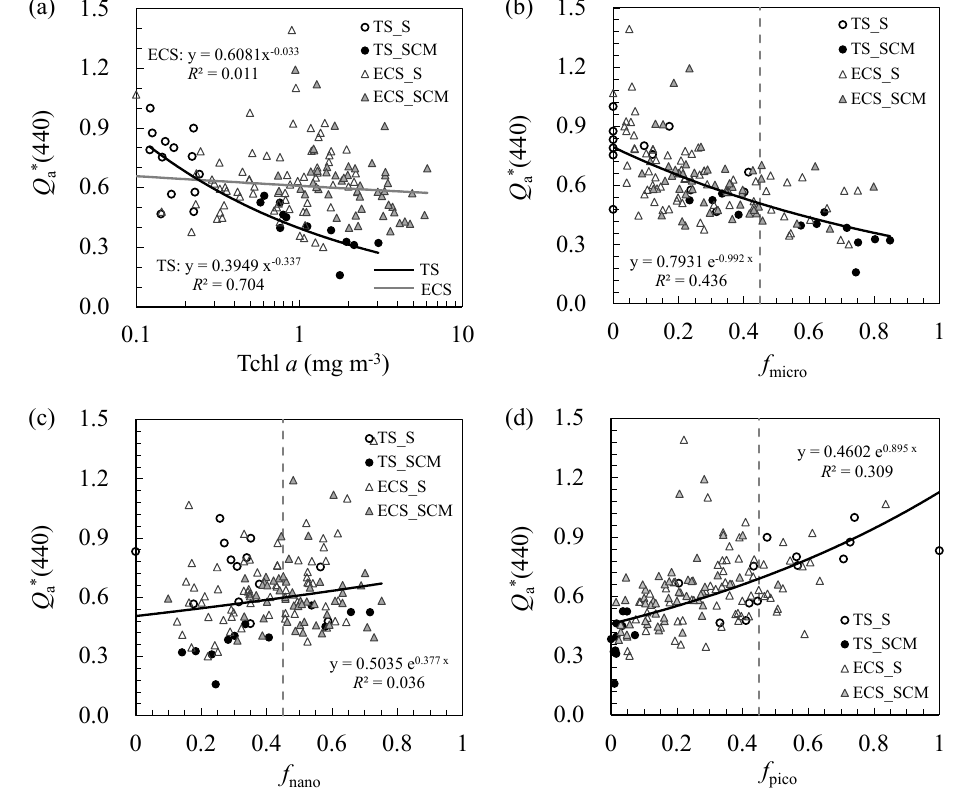
Fig. 4. Variations in Q ∗ a ( 440 ) as a function of Tchl a (a) and Tchl a size-fractions of micro- (b) , nano- (c) , and pico-phytoplankton (d) for samples from the Tsushima Strait surface (TS_S), Tsushima Strait SCM (TS_SCM), East China Sea surface (ECS_S), and East China Sea SCM (ECS_SCM). In (a) , black and grey lines indicate power law functions fitted in the Tsushima Strait (TS) and East China Sea (ECS). In Fig. 4 (b–d) , black lines indicate exponential functions fitted from all samples, and grey vertical dashes are the boundaries of the dominant class with a fraction > 0 . 45.